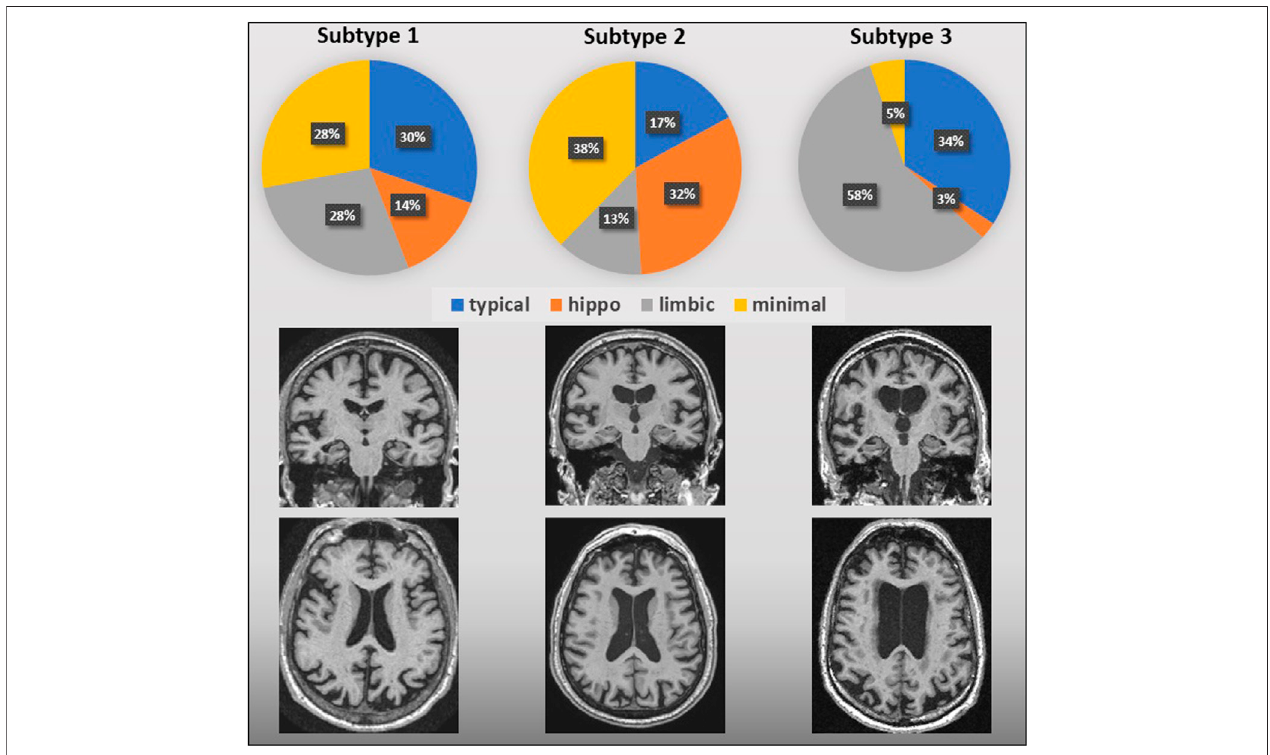
FIGURE 2 | AVRA vs. SuStaIn subtypes of AD. Pie graphs represent the percentage of AVRA subtypes subjects for each SuStaIn subtype. Regional atrophy in AVRA was measured with the MTA, PA and GCA-F scales based on T1-3D weighted images; below, visual examples of the SuStaIn atrophy subtypes are shown.